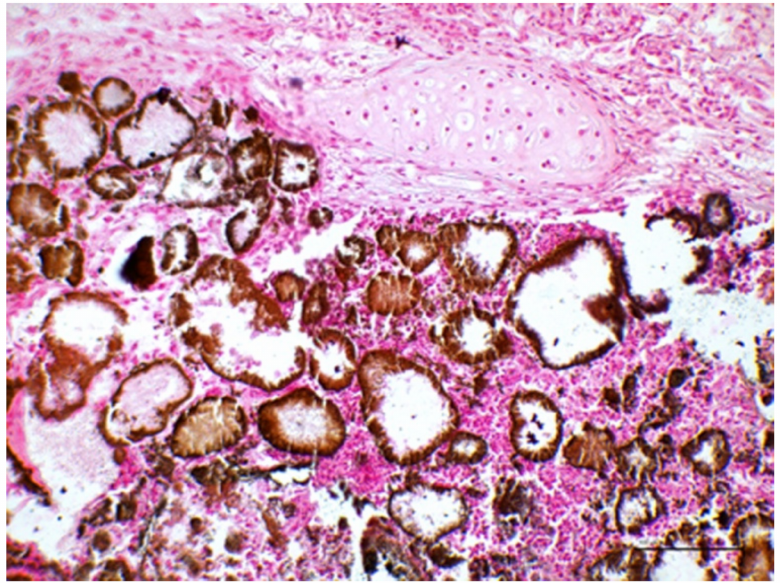
Figure 6. Lungs. Calcium salt deposits appear brown-black and are abundantly accumulated within the airways, particularly along the alveolar surfaces, thereby thickening the alveolar wall and partially obliterating the alveolar lumina (Von Kossa stain, magnification × 200, bar = 100 µ